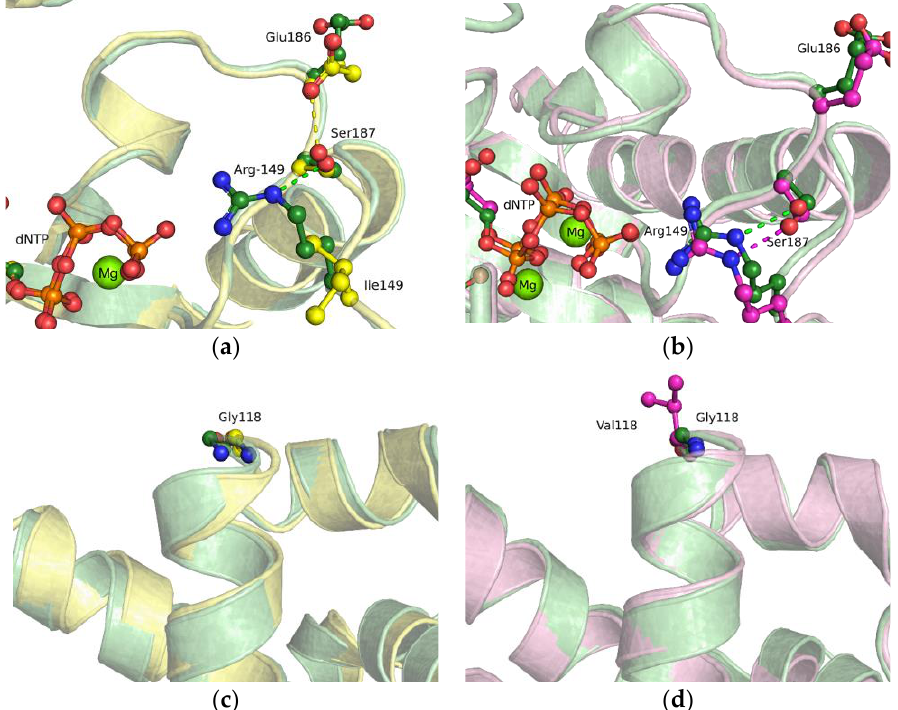
Figure 7. An overlay of WT Polβ (green), G118V (magenta), and R149I (yellow) snapshots of the Arg149 region ( a , b ) or Gly118 region ( c , d ) in the ternary enzyme–DNA–dNTP complex. Hydrogen bonds are presented as dashed lines.